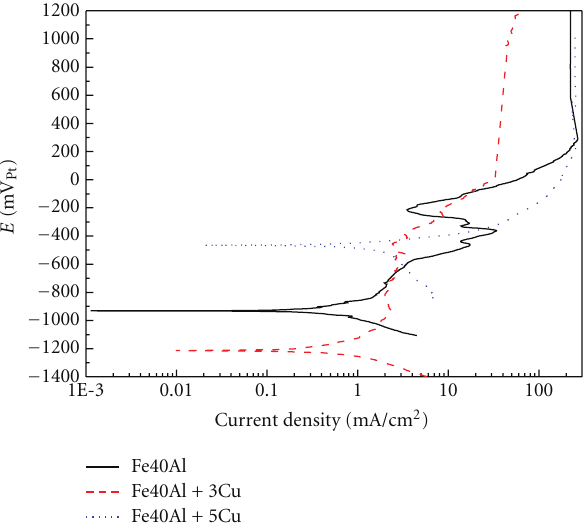
Figure 3: E ff ect of Cu on the polarization curve for Fe40Al alloy in NaCl-KCl (1:1 molar ratio) salt in static air at 670 ◦